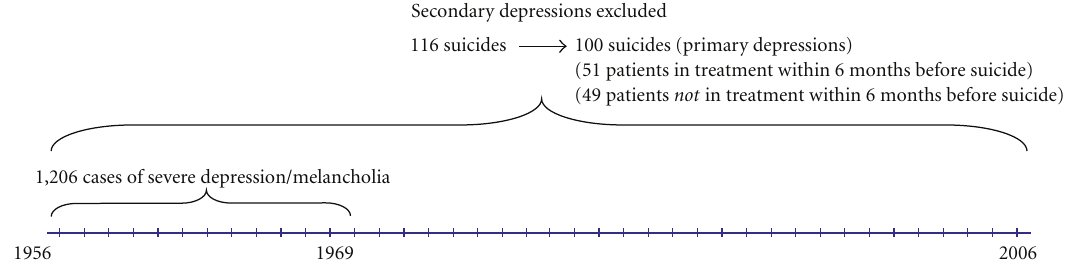
Figure 1: Flow-diagram for the sample of patients with severe depression admitted to the Department of Psychiatry, Lund University Hospital.